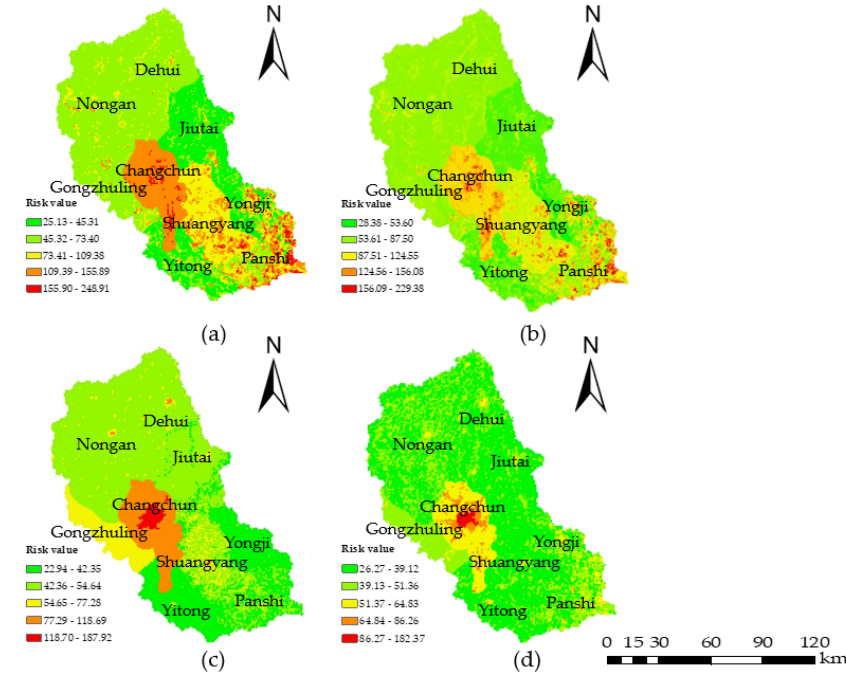
Figure 7. Water environmental risk maps of ( a ) 2000; ( b ) 2005; ( c ) 2010; and ( d ) 2015. The color scale from green to red represents slightly risky, lightly risky, moderately risky, highly risky, and extremely risky, respectively.